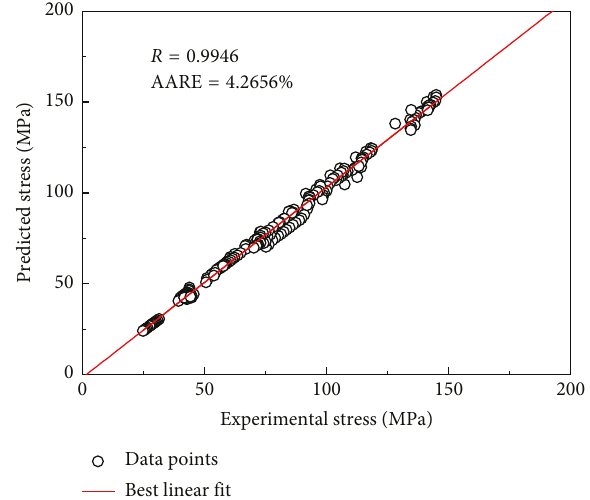
Figure 6: Correlation between the experimental and the predicted flow stress from the constitutive models based on orthogonal analysis for the AA6061 alloy under